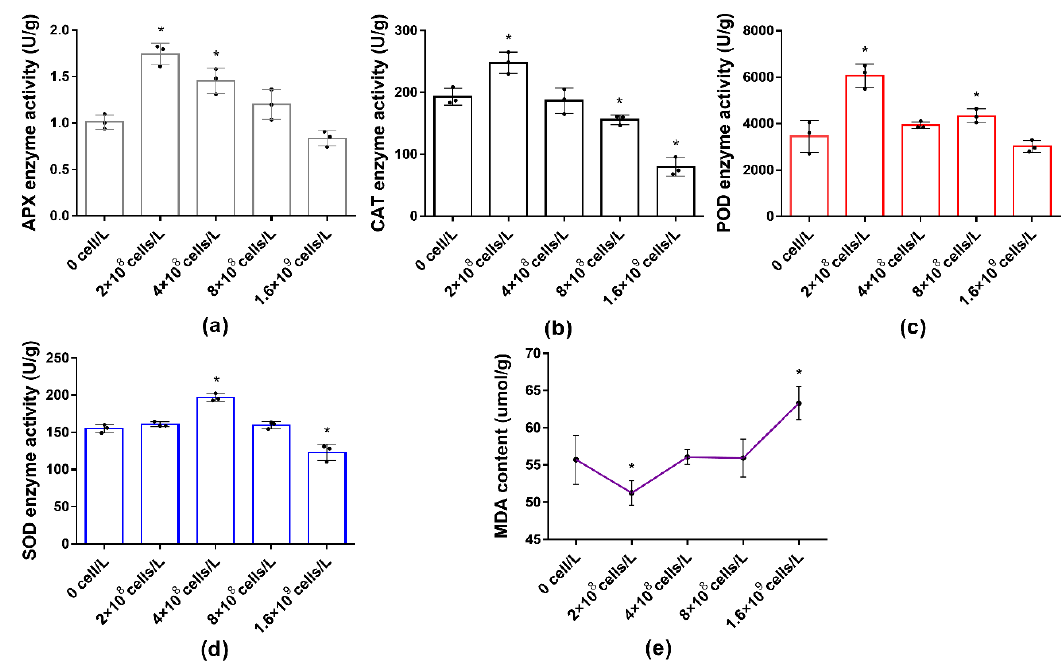
Figure 4. L. punctata APX (ascorbate peroxidase), CAT (catalase), POD (peroxidase), and SOD (superoxide dismutase) activity and MDA (malondialdehyde) content after co-culturing with M. aeruginosa . ( a ) APX activity. ( b ) CAT activity. ( c ) POD activity. ( d ) SOD activity. ( e ) MDA content. Values are means ± SE from three biological replicates. Asterisks indicate statistical significance based on one-way ANOVA; * p < 0.05.